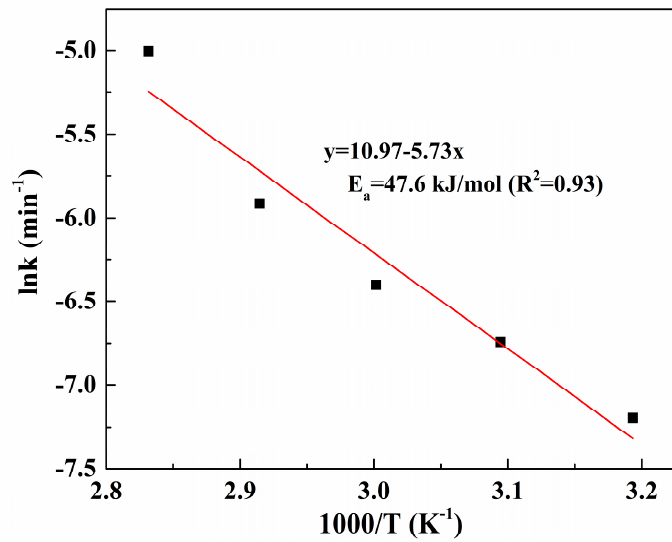
Figure 8. Arrhenius plot for the leaching of Pd in the temperature range 313.15–353.15